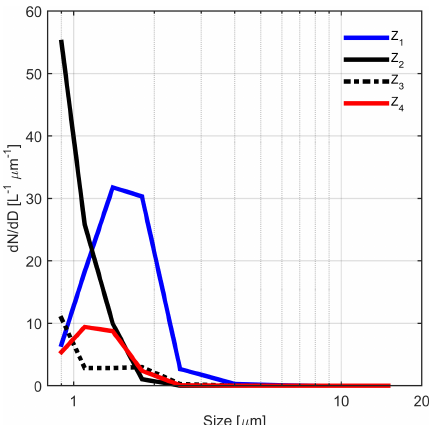
Figure 7. Size distribution of BEACHON z -score-normalised clus- ters produced using the Ward linkage for the period 00:00 to 06:00MST 27 July